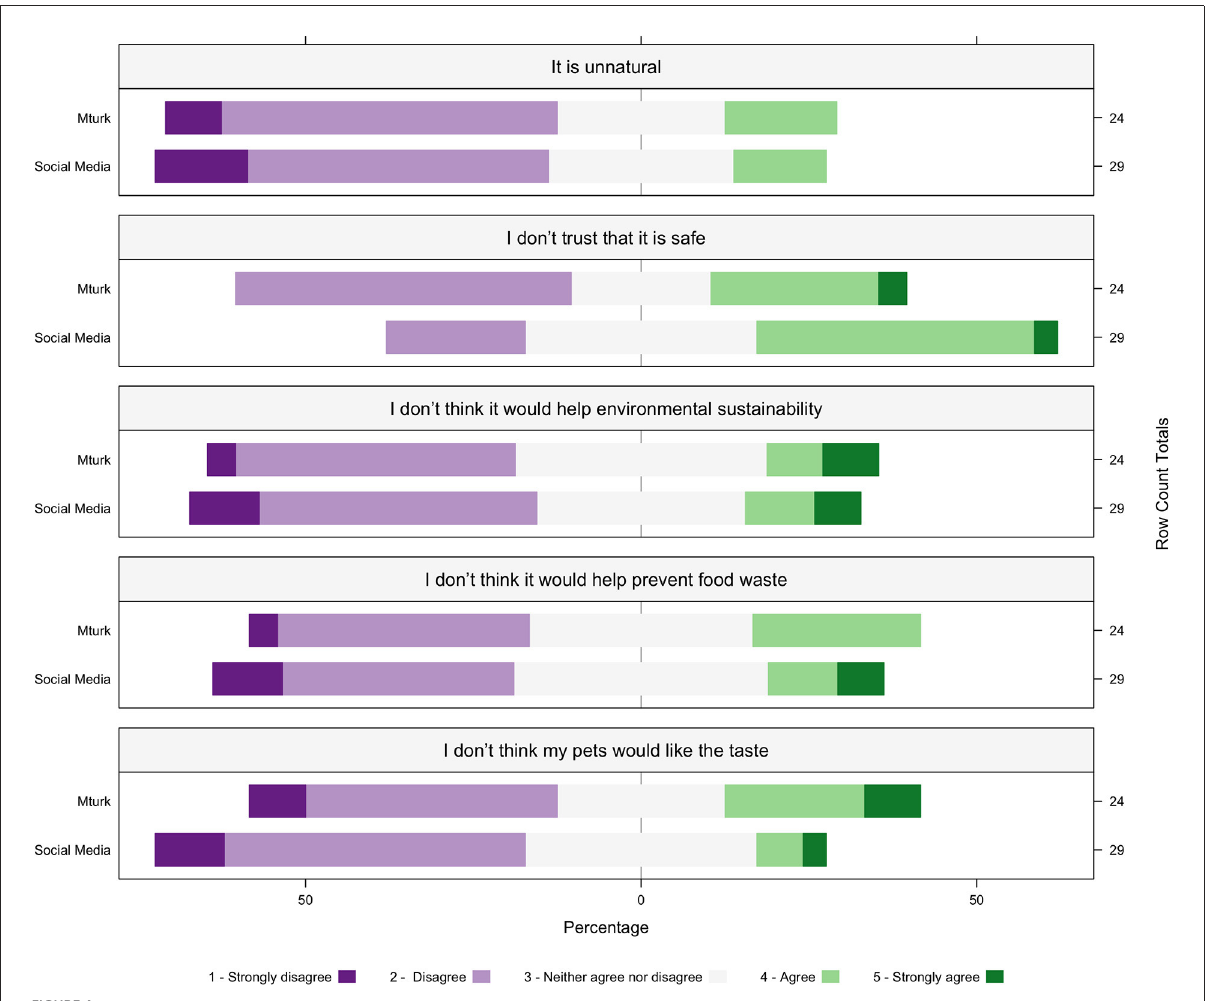
FIGURE4 The percentage within each recruitment source MTurk (MT; n = 24) and social media (SM; n = 29) of consumer agreement with objections to bacteriophage applications. Participants reported to “Strongly Disagree,” “Disagree,” “Neither agree Nor Disagree,” “Agree,” or “Strongly Agree” to each attitude toward sustainability statements listed in the box above each corresponding plot. The percentage of participants within each recruitment source is represented on the x-axis, the recruitment source is represented on the left y-axis, and the row count totals (the number of participants for each question within each recruitment source) are listed on the right y-axis for each